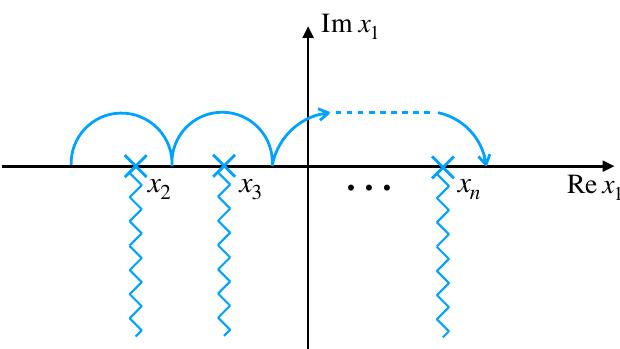
Figure 2 . Analyticity structure of n -point correlation function is established by consecutively hopping around the n − 1 operators in the complex x 1 plane. The branch cuts are chosen to stretch along the negative imaginary